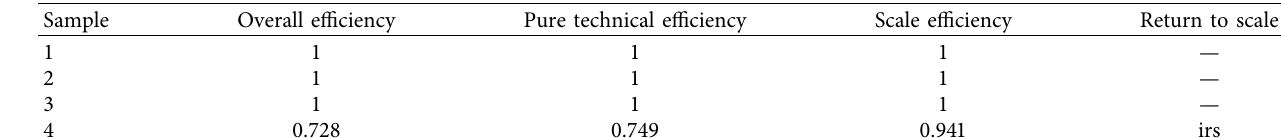
Table 5: Analysis of input-output efficiency value.